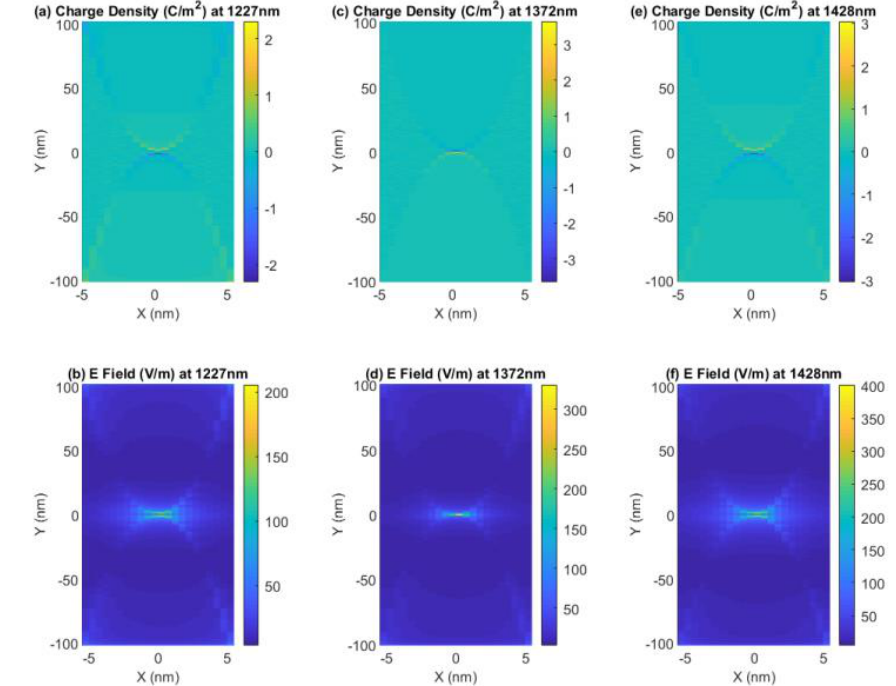
Figure 5. Charge density and electric field distribution on surface of the PGNB at the resonance wavelength with the maximum field enhancement factor at the gap corresponding to Figure 4b,d,f. ( a ) Charge density at resonance wavelength 1227 nm with a wing width of 10 nm; ( b ) Electric field distribution at resonance wavelength 1227 nm with a wing width of 10 nm; ( c ) Charge density at resonance wavelength 1372 nm with a gap size of 0.9 nm. ( d ) Electric field distribution at the resonance wavelength 1372 nm with a gap size of 0.9 nm. ( e ) Charge density at resonance wavelength 1428 nm with a thickness of 20.5 nm. ( f ) Electric field at resonance wavelength 1428 nm with a thickness of 20.5 nm. Table 1. Scattering, absorption, extinction cross section, absorption ratio, and resonance shift depend on geometry of the PGNB on a sapphire